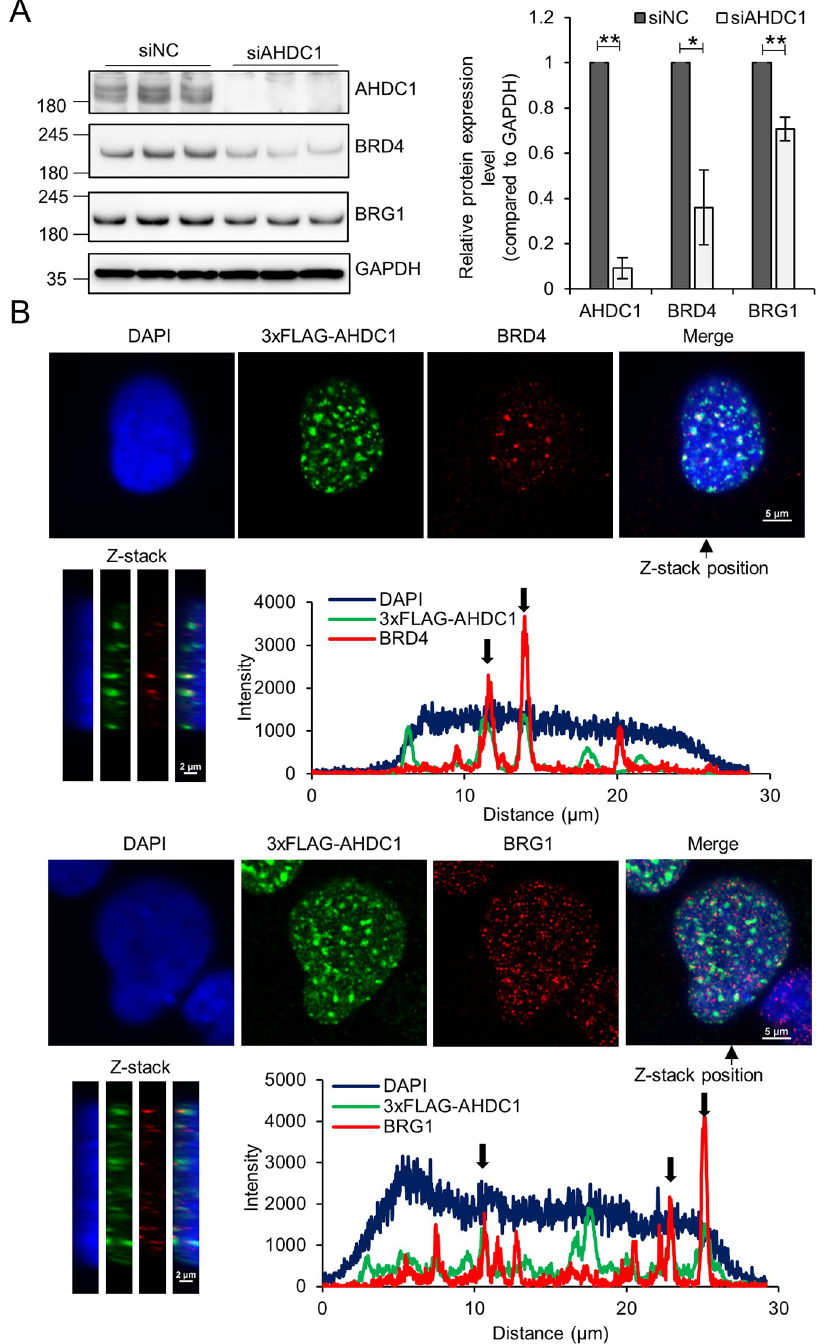
Fig 5. AHDC1 knockdown reduces BRD4 and BRG1 in A673 cells. (A) siAHDC1-treated cells were collected for western blotting. Each antibody detected the respective protein, and the relative value was normalized by GAPDH. (B) 3xFLAG-AHDC1 was induced by 0.1 μ g/ml doxycycline for 1 day, fixed, and permeabilized. Scale bar, 5 μ m. Z-stack scale bar, 2 μ m. P values were calculated by the student’s t-test. � p < 0.05; �� p < 0.001.